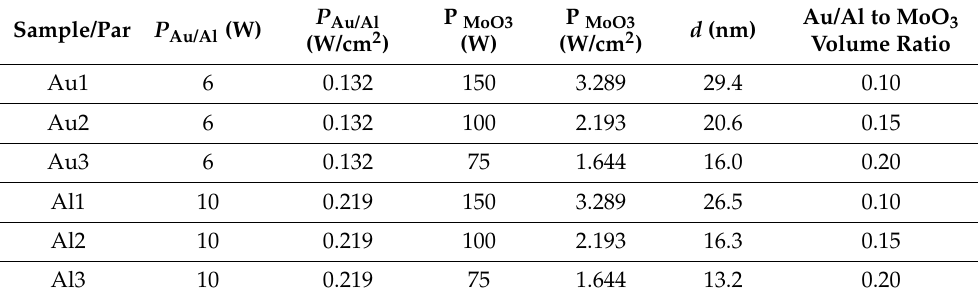
Table 1. Deposition parameters of the films. P indicates the sputtering power of the correspond- ing target, d is the film thickness determined from grazing-incidence small-angle X-ray scattering (GISAXS) measurements and Au/Al to MoO 3 shows the targeted volume ratio of the metal to the matrix.